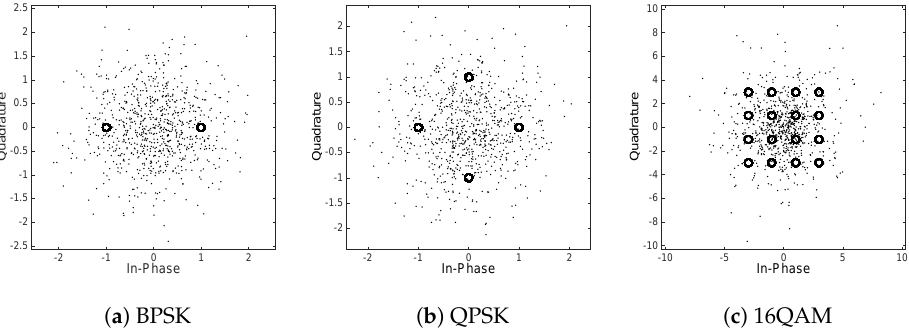
Figure 6. Constellations of the received 800 symbols with bit signal to noise ratio γ b = 20 dB, where its corresponding digital modulation constellation is represented by the marker “o”.